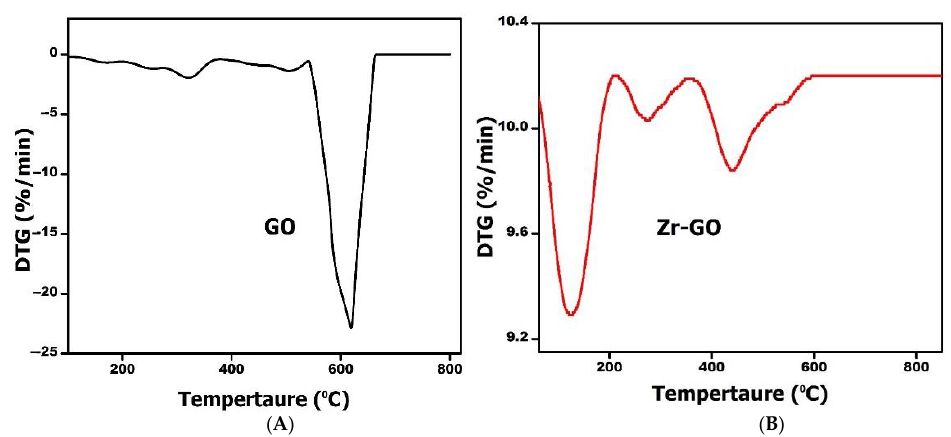
Figure 7. DTG thermogram for GO ( A ) and Zr-GO ( B ).